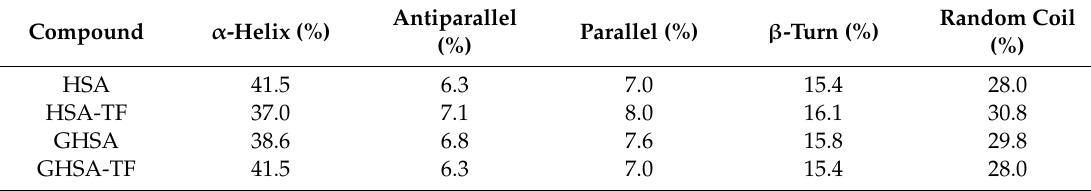
Figure 6. The effect of the site marker on the characteristic fluorescence of HSA ( A ) and GHSA ( B ) at the wavelength of maximum fluorescence intensity. 2.8. Molecular Docking Experiment The binding mode of TF and HSA/GHSA was predicted by computer simulation of molecular docking techniques. The specific results of the combination were shown in Figure 7. The figure